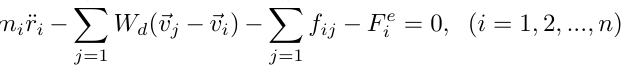
noise, white noise and pink noise. Those are available to